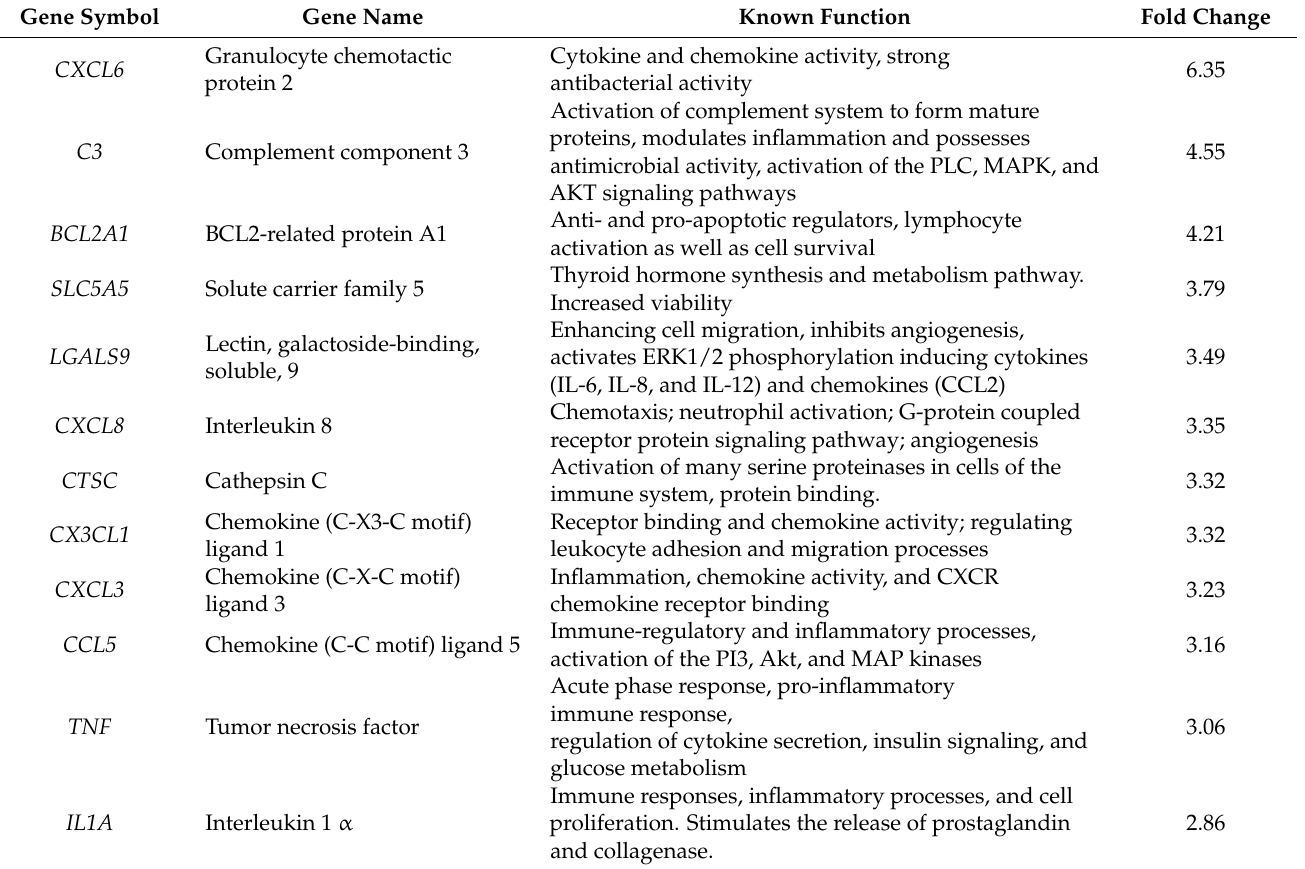
Table 2. List of top 12 overexpressed genes ( ≥ 3-fold change) in detected DEGs related to cell proliferation and